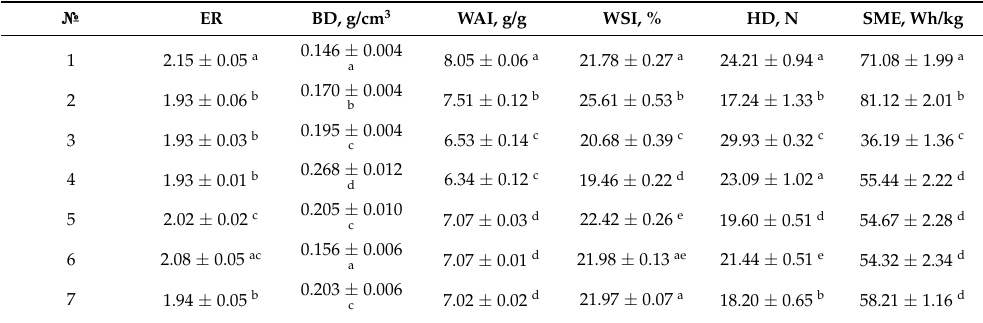
Table 2. Experimental results for physical and functional characteristics of extrudates.